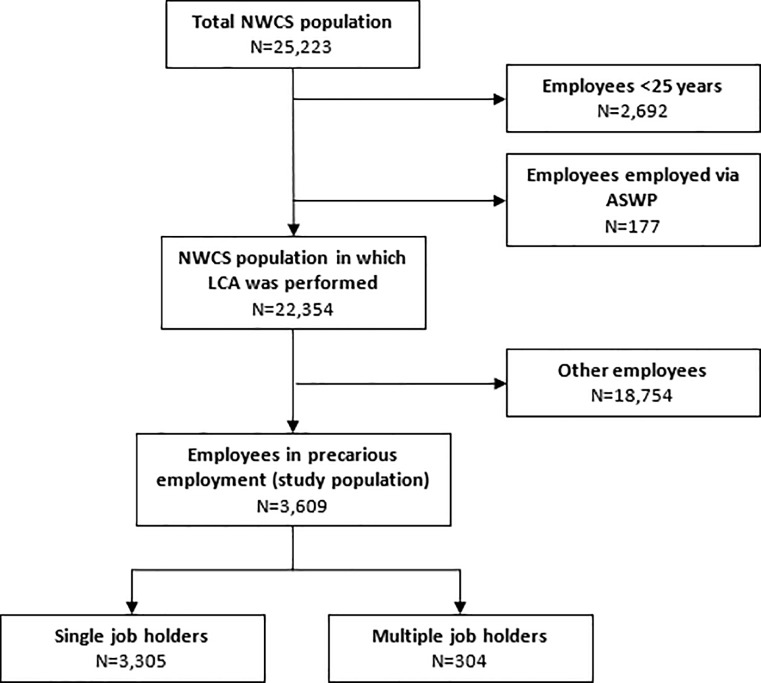
Study population.